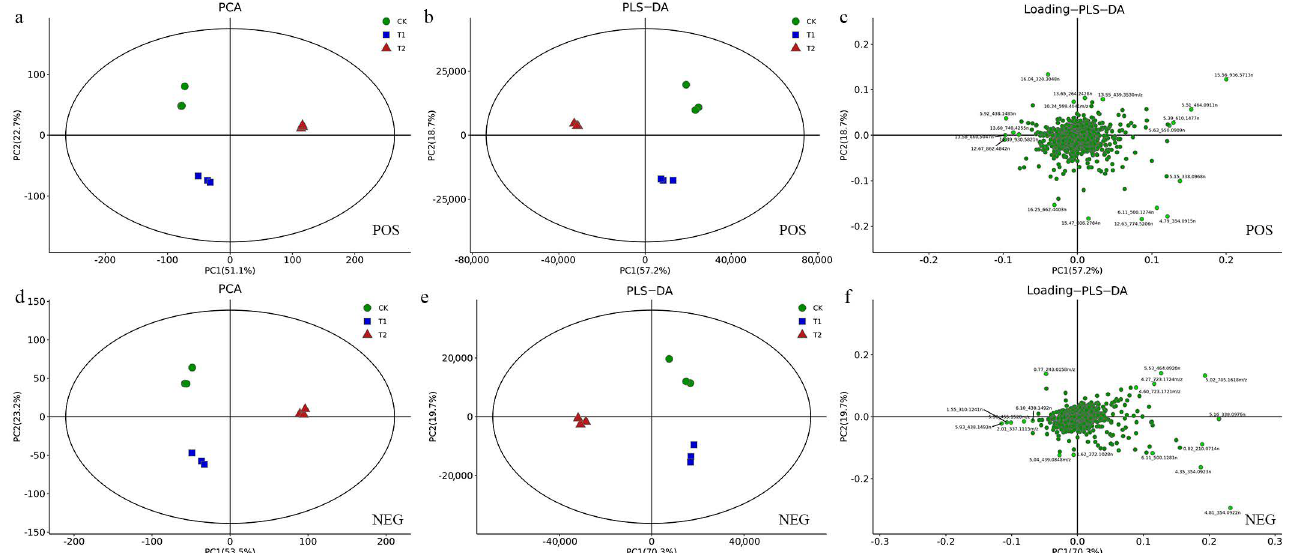
Figure 2. Multivariate statistical analysis of blueberry samples in positive and negative ion modes. Principal component analysis in positive ( a ) and negative ion modes ( d ); partial least-squares dis- criminant analysis score chart in positive ( b ) and negative ion modes ( e ); and loading plot in positive ( c ) and negative ion modes ( f